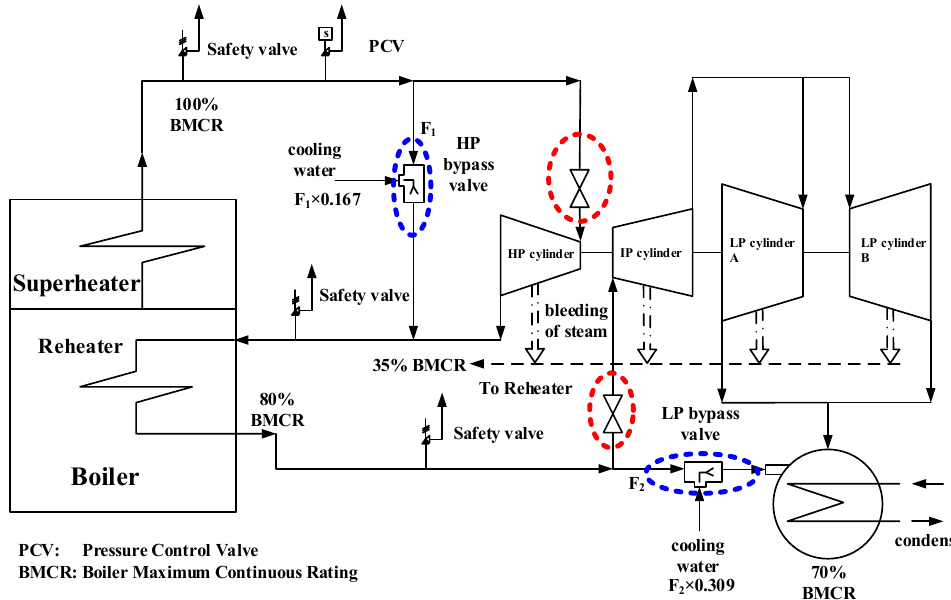
Figure 6. The Structure diagram of the FCB steam turbine.